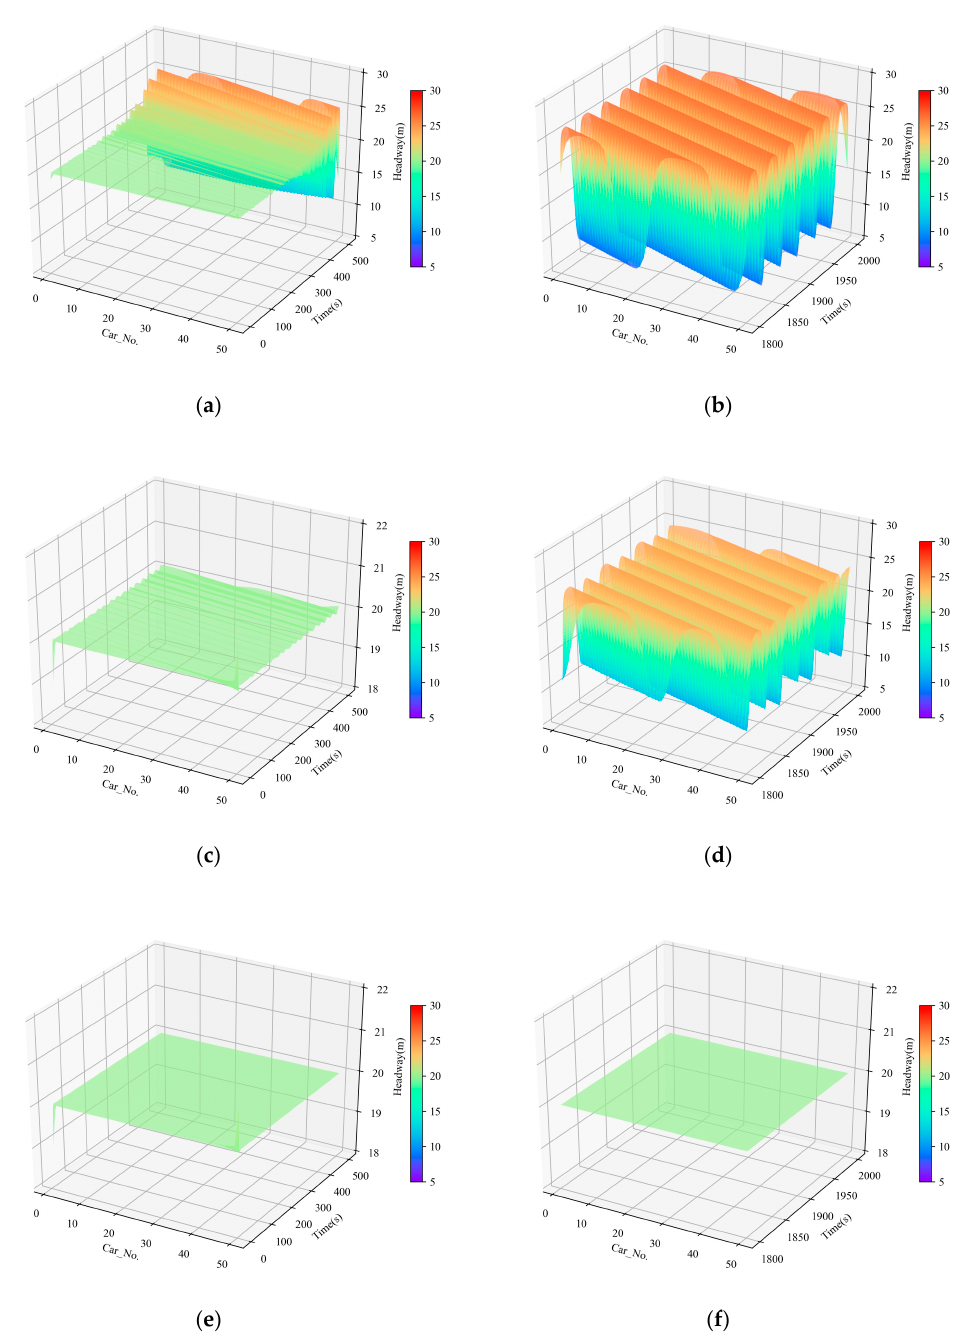
Figure 3. Evolution of space-time evolution in headway for di ff erent parameters.: ( a , b ) β = 0, p = 0, m = 1; ( c , d ) β = 0.1, p = 0.1, m = 1; ( e , f ) β = 0.2, p = 0.2, m =